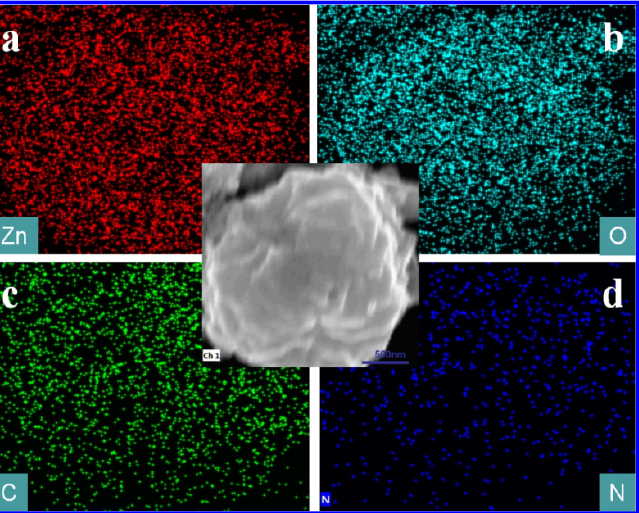
Figure 2. Mapping of ZnCDs/ZnO@ZIF-8 composites ( a ) Zn ( b ) O ( c ) C ( d ) N. XRD analysis of ZnCDs/ZnO@ZIF-8 shows a series of typical characteristic peaks with 2 θ at 7.32° (39.0), 10.36° (41.7), 12.71° (44.8), 14.68° (56.5), 16.42° (40.5), 18.01° (41.4), and 22.09° (54.5), because of the (011), (002), (112), (022), (013), and (222), (114) diffraction of ZIF-8 [30]; and the obvious diffraction peaks at 31.77° (2.81), 34.43° (2.60), 36.26° (2.47), 47.55° (1.91), 56.61° (1.62), 62.87° (1.47), and 67.96° (1.37), respectively, correspond to the (100), (002), (101), (102), (110), (103), and (112) of the tetragonal phase ZnO (JCPDS, No. 89-0511) [31] (Figure 3a). The interplanar distances are listed in the parentheses, respectively. It shows that ZnCDs/ZnO@ZIF-8 composites were successfully synthesized.